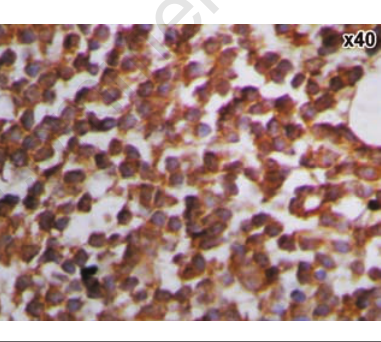
Figure 3. A case of chronic lymphocytic leukemia showing positive CD20.